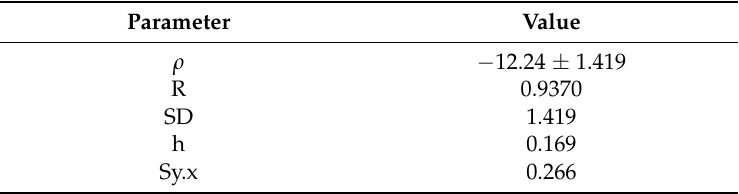
Table 3. Summary of results of simple Hammett equation fit.